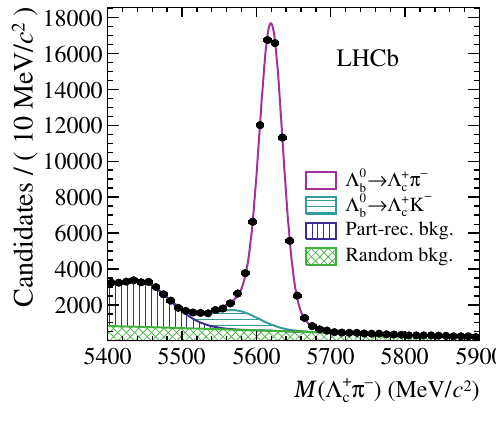
Figure 13. Invariant mass distribution for Λ 0 b → Λ + c π −